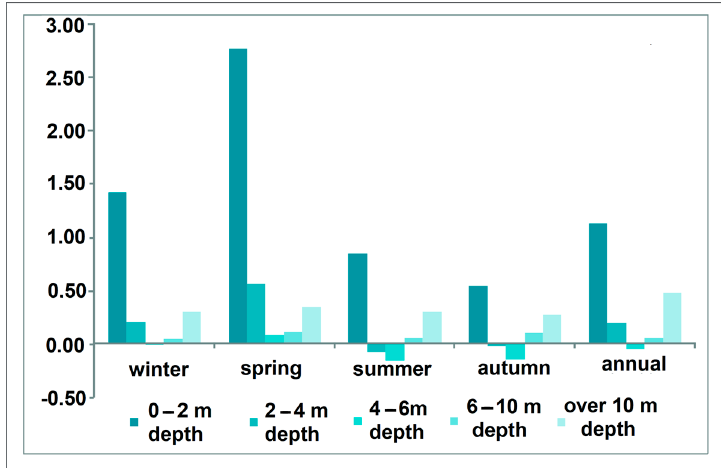
Figure 8. Changes in seasons and annual groundwater level according to the ITA index for different groundwater level depths classes.